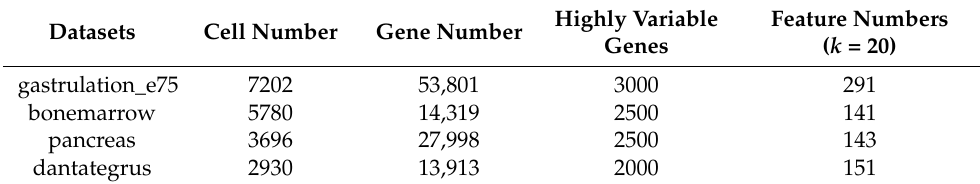
Table 1. Description of cells and genes in each